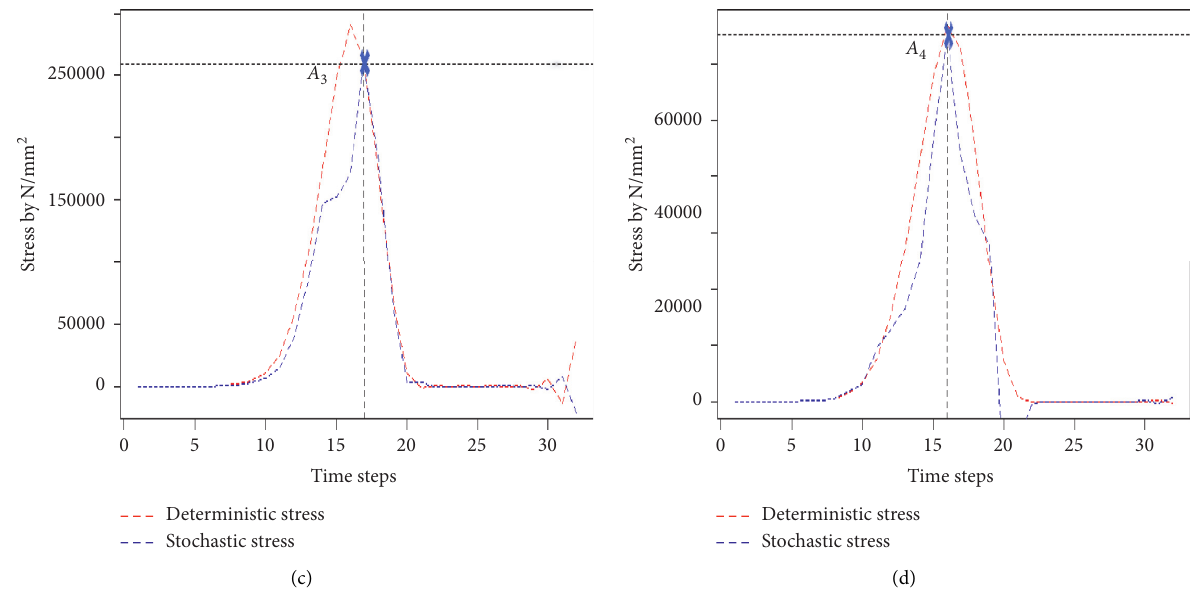
Figure 6: Simulation of the stress density for some joint elastic piece thicknesses using their corresponding estimating models. (a) Thickness � 0, A 1 (16, 70236), (b) thickness � 0.1, A 2 (16, 51191), (c) thickness � 0.4, A 3 (17, 259276), and (d) thickness � 0.7, A 4 (16, 65108). Table 5: Results of the simulation: stress peak value, stress peak time, and stress extinction time. Elastic piece thickness (mm)